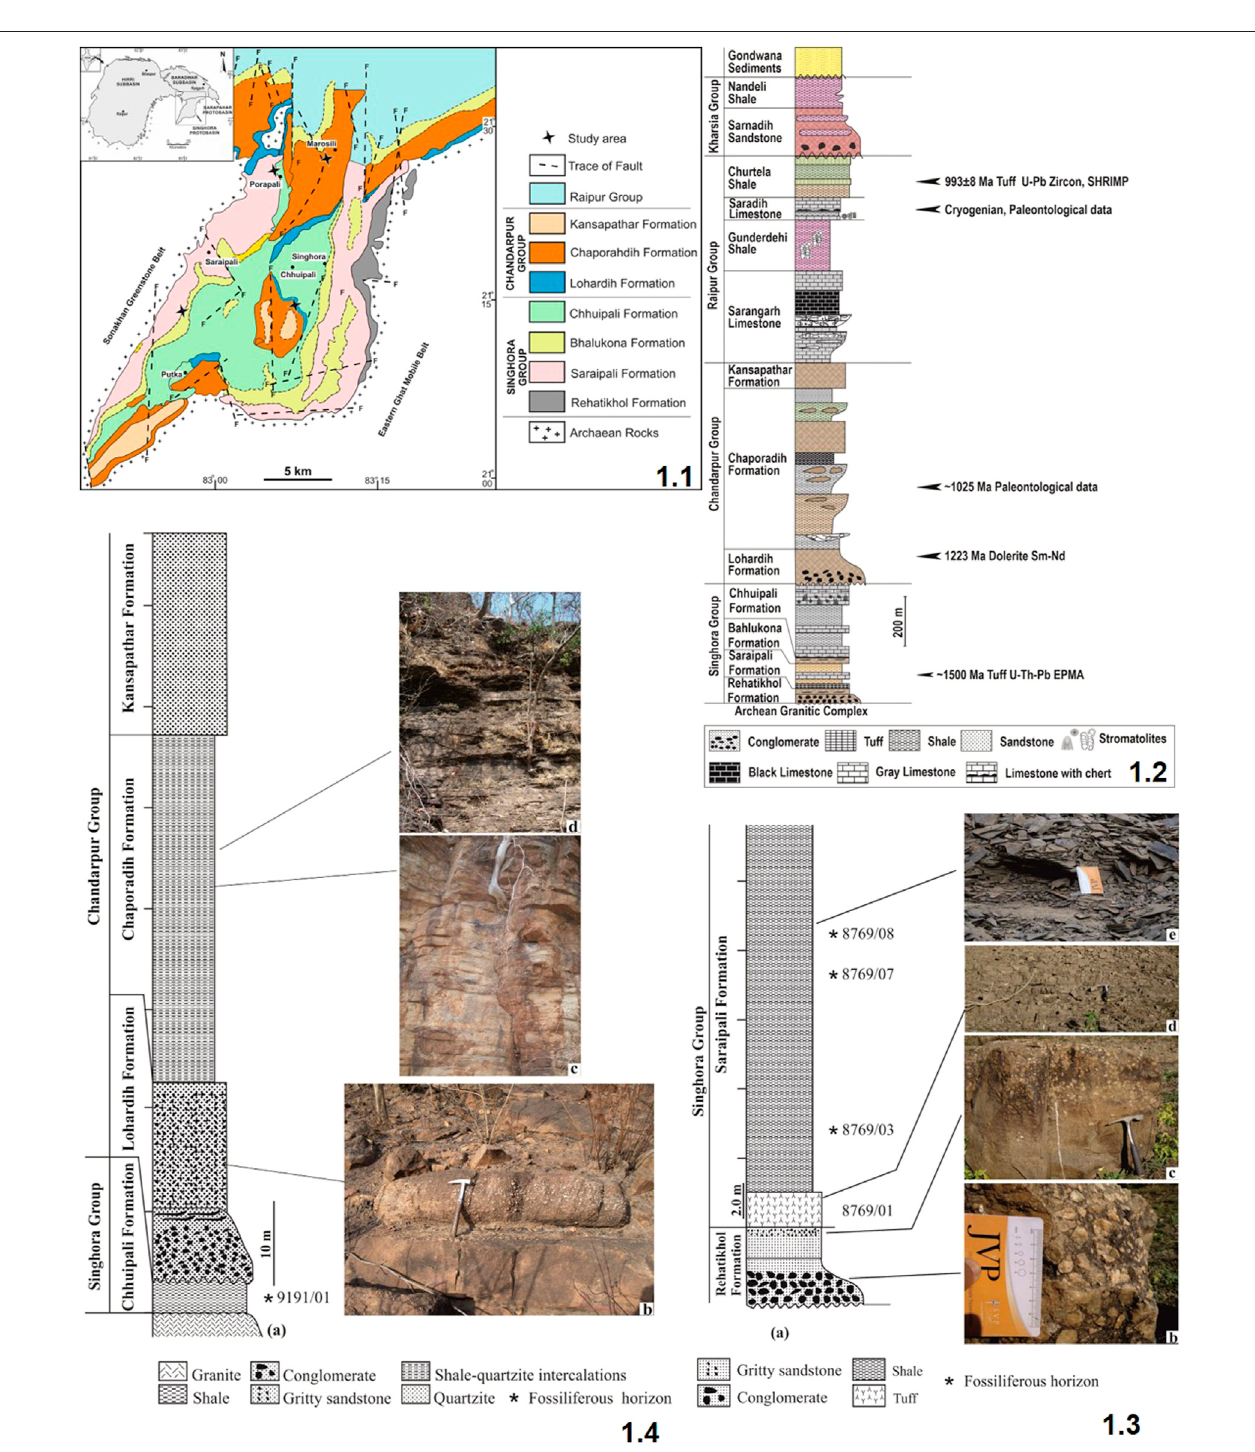
FIGURE 1 | Generalized geological map of the Baradwar Subbasin in and around the Singhora and Sarangarh areas, Chhattisgarh (after Das et al., 2001); 1.2: LithostratigraphicsuccessionoftheChhattisgarhSupergroupintheBaradwar Subbasin(modi fi edafterDasetal.,1992;PatranabisdebandChaudhury,2008);1.3: (A) Generalized lithology oftheSinghora Group, Surangi River section; (B) Conglomerate oftheRehatikhol Formation; (C) Gritty sandstone oftheRehatikholFormation; (D) Tuff/porcellanite of the Saraipali Formation; (E) Fossil bearing carbonaceous shale of the Saraipali Formation. Card and geological hammer used for scale; 1.4: (A) Generalized lithology of Bendla Dongar section; (B) Gritty sandstone of the Lohardih Formation; (C , D) Shale-quartzite intercalation heterolithic of the Chaporadih Formation. Hammer is used for scale.